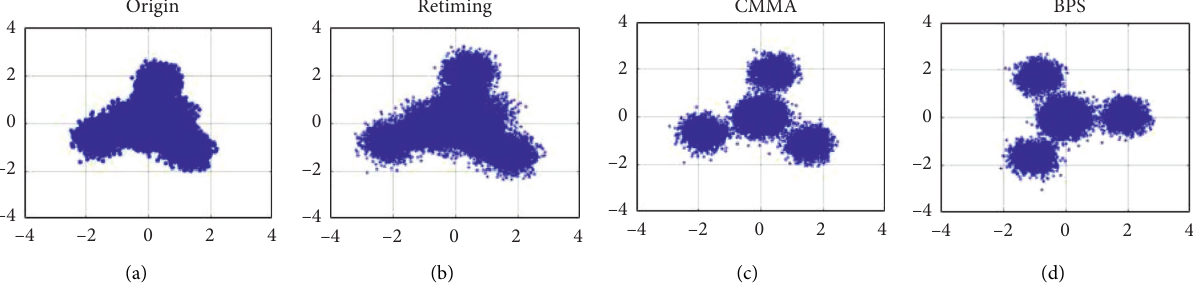
Figure 5: Constellation for the 4 Gbit/s over 5 km SMF transmission when the received optical power is − 27 dBm: (a) the constellation of the original signal; (b) the constellation after clock extraction; (c) the constellation after CMMA; (d) the constellation after BPS.